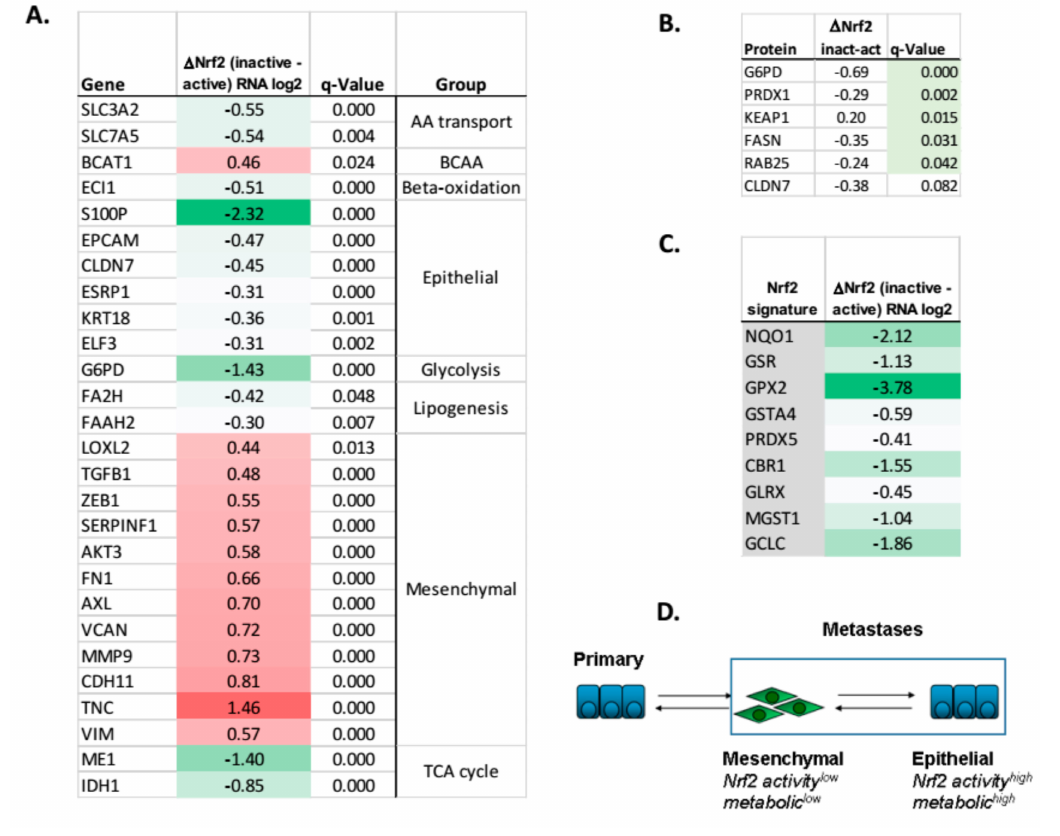
Figure 8. Attenuation of Nrf2-dependent transcription correlates with EMT and metabolic RNA and protein abundance in NSCLC adenocarcinomas. ( A ) Co-correlation of Nrf2 target RNA expression (anchor genes NQO1, GSR, GPX2, GSTA4, PRDX5, CBR1, GLRX, MGST1, GCLC) with a reference 85 gene EMT signature defined [60]. The TCGA Provisional 503 patient lung adenocarcinoma